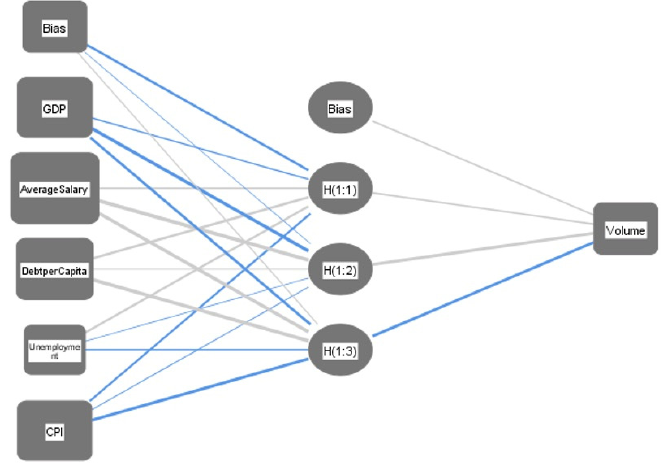
Figure 2. Artificial Neural Network Volume.